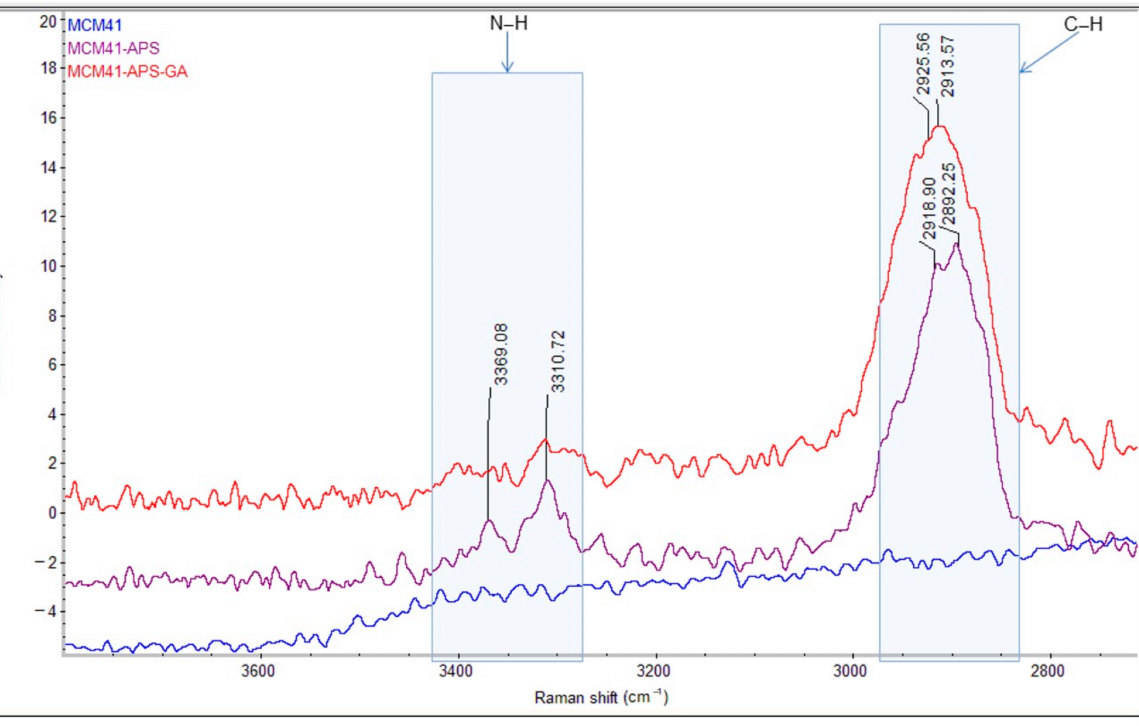
Figure 8. Comparative Raman spectra of MCM-41, MCM-41/APS, and MCM-41/APS/GA